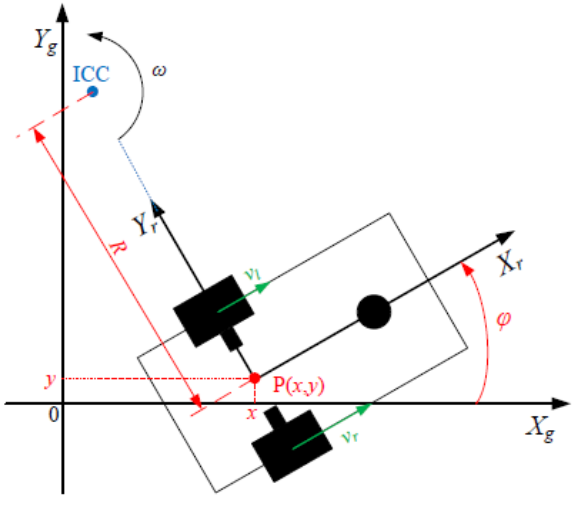
Figure 3. Robot location in the global coordinates (reference system ).